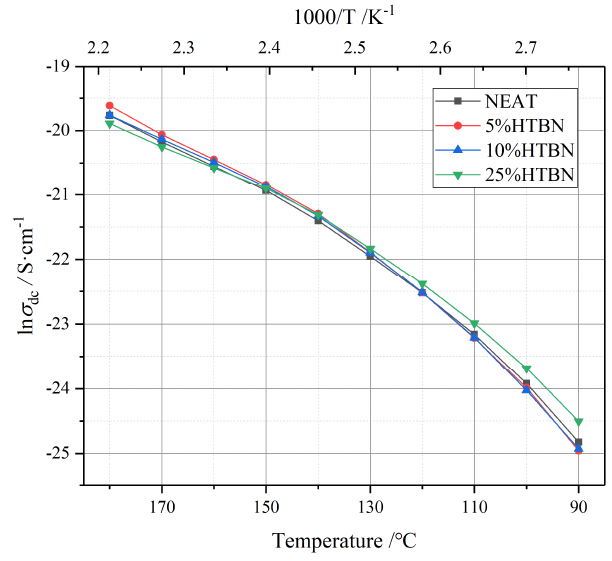
Figure 12. HN-equation fitting results of DC-conductivity with different HTBN contents from 90 °C to 180 °C. Table 3. Arrhenius equation fitting results of